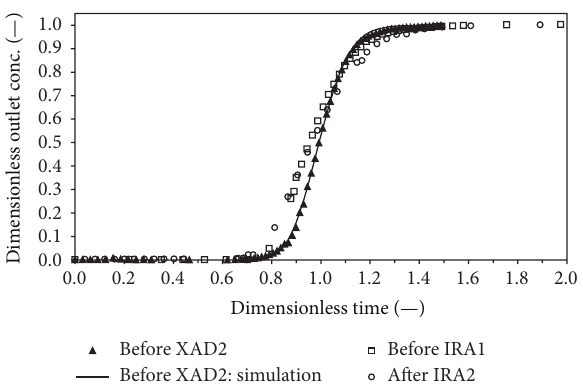
Figure 2: Fluid-dynamic tests conducted in the 1.8 m column: experimental points and, only for resin XAD16, best-fitting simu-